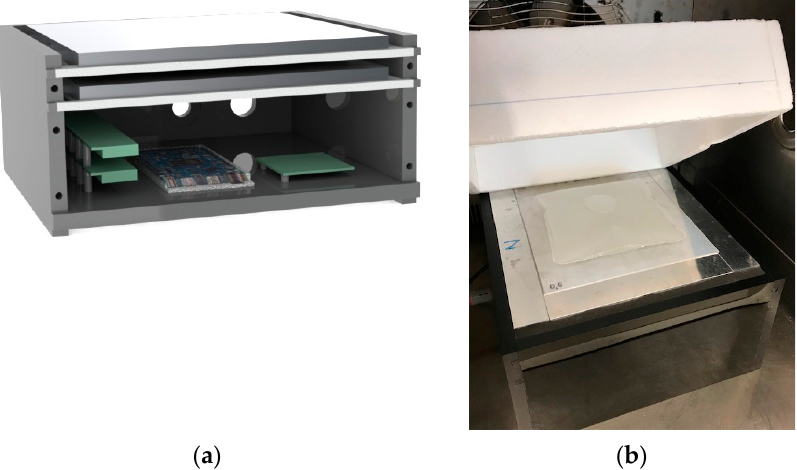
Figure 1. ( a ) Hotplate design consisting of top aluminum plate, heating elements and control elec- tronics; ( b ) Hotplate with silicone rubber insulation layer, ice pack and styrene